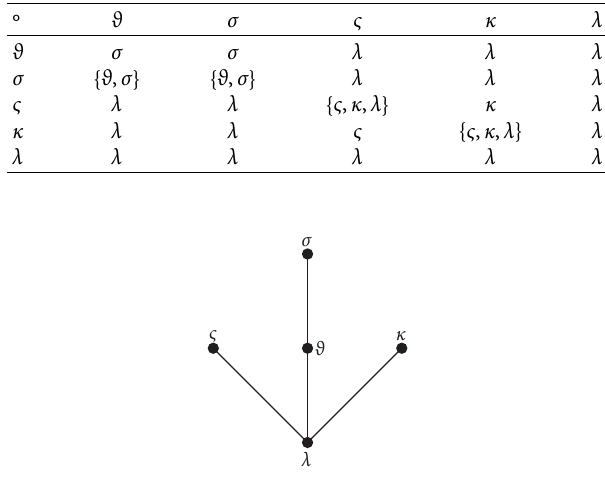
Table 2: Left almost semihypergroup ( Θ � ϑ , σ , ς , κ , λ { } , °